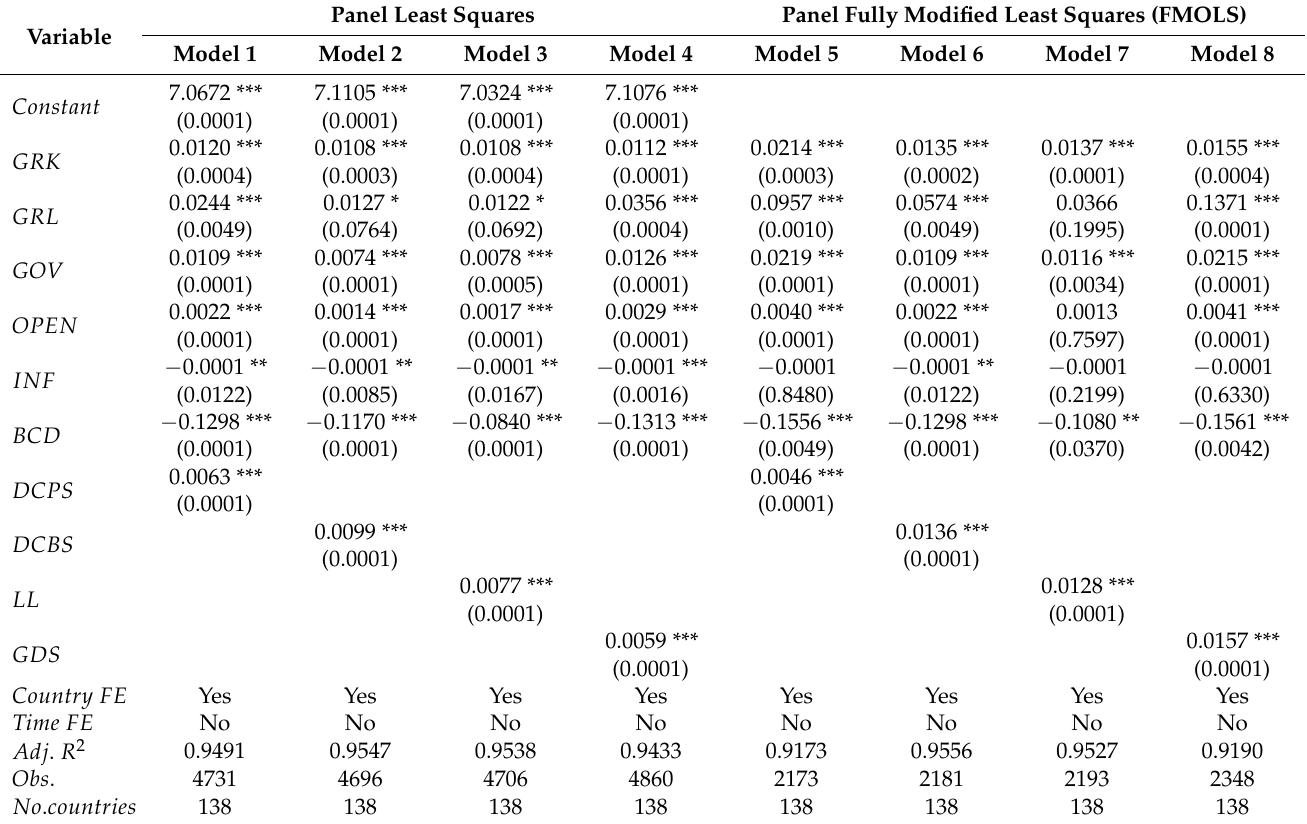
Table 3. Economic growth regressions (all-countries